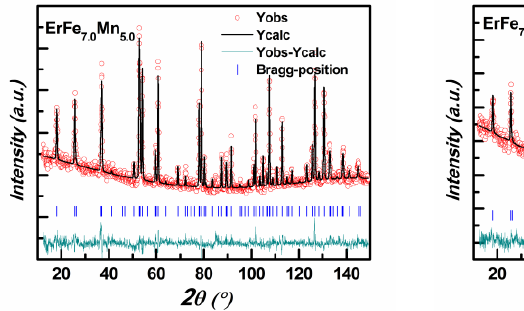
Figure 2. Refined neutron diffraction pattern of ErFe x Mn 12−x (7.0 ≤ x ≤ 9.0) series alloys (where red dots are experimental data, black curves are theoretical simulations, blue vertical bars are Bragg diffraction peak positions and the bottom green solid line is the difference curve). Table 1. Information on crystal structure parameters of ErFe x Mn 12−x (7.0 ≤ x ≤ 9.0) series alloys.